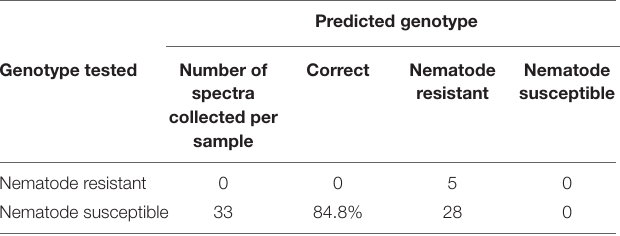
TABLE 7 | Prediction results of Tamrun OL11 using PLS-DA model from Table 6 .